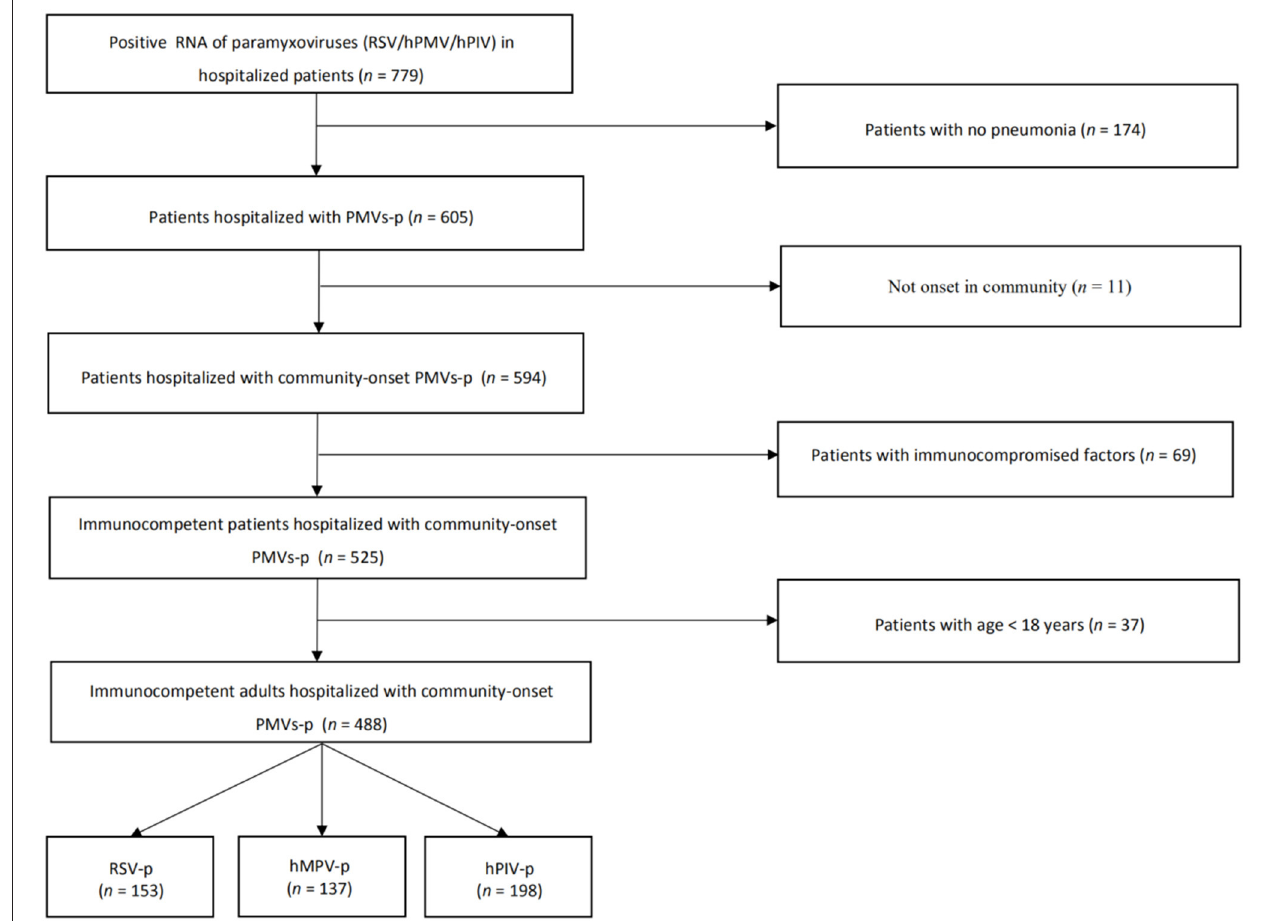
FIGURE 1 | Screening algorithm of patients hospitalized with the three types of PMVs-p.